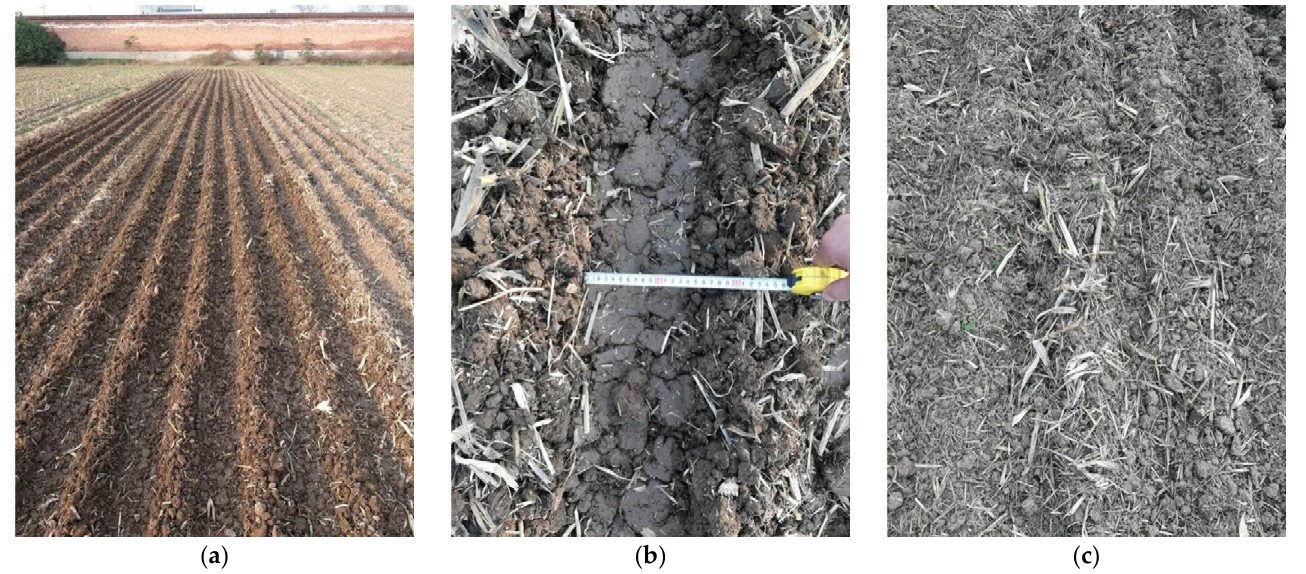
Table 6. Field test results of straw cleaning effect of sowing strip.